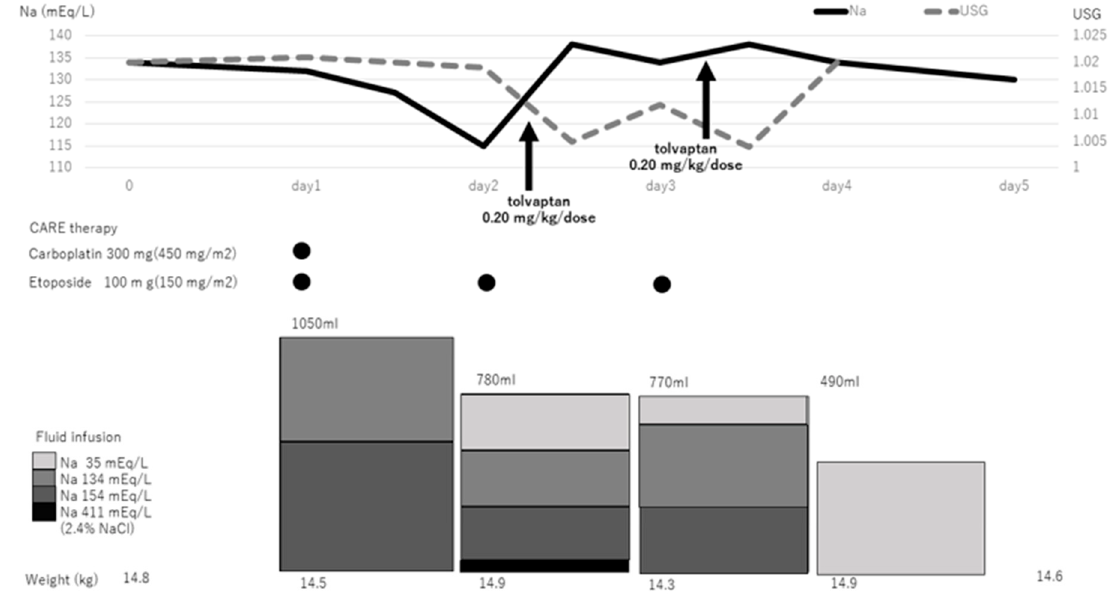
Figure 1. The first cycle of CARE chemotherapy. USG, urine specific gravity; CARE, carboplatin and etoposide combination chemotherapy.